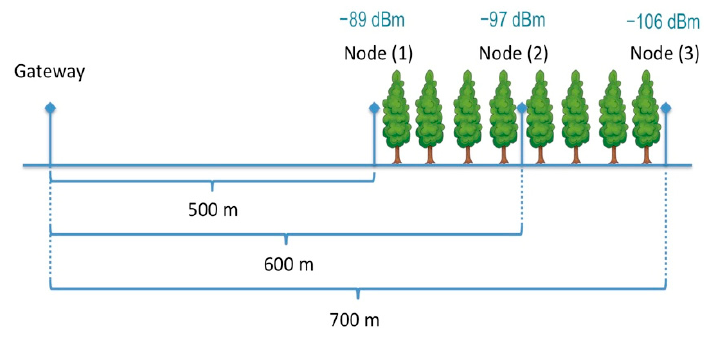
Figure 16. Forest case.